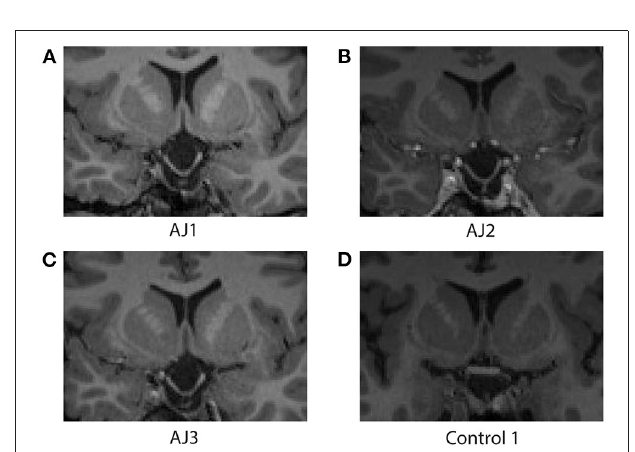
FIGURE 7 | Coronal images at the level of the optic chiasm obtained from the T1-MPRAGE MRI sequence associated with each diffusion MRI scan for patient AJ at all time points; (A) AJ1, (B) AJ2, (C) AJ3, and for a representative control participant (D) . Notably, there are no macrostructural differences observed across time for patient AJ, who demonstrates stable downward herniation of the chiasm compared with controls. Supplementary Figure 4 reports coronal images of each control